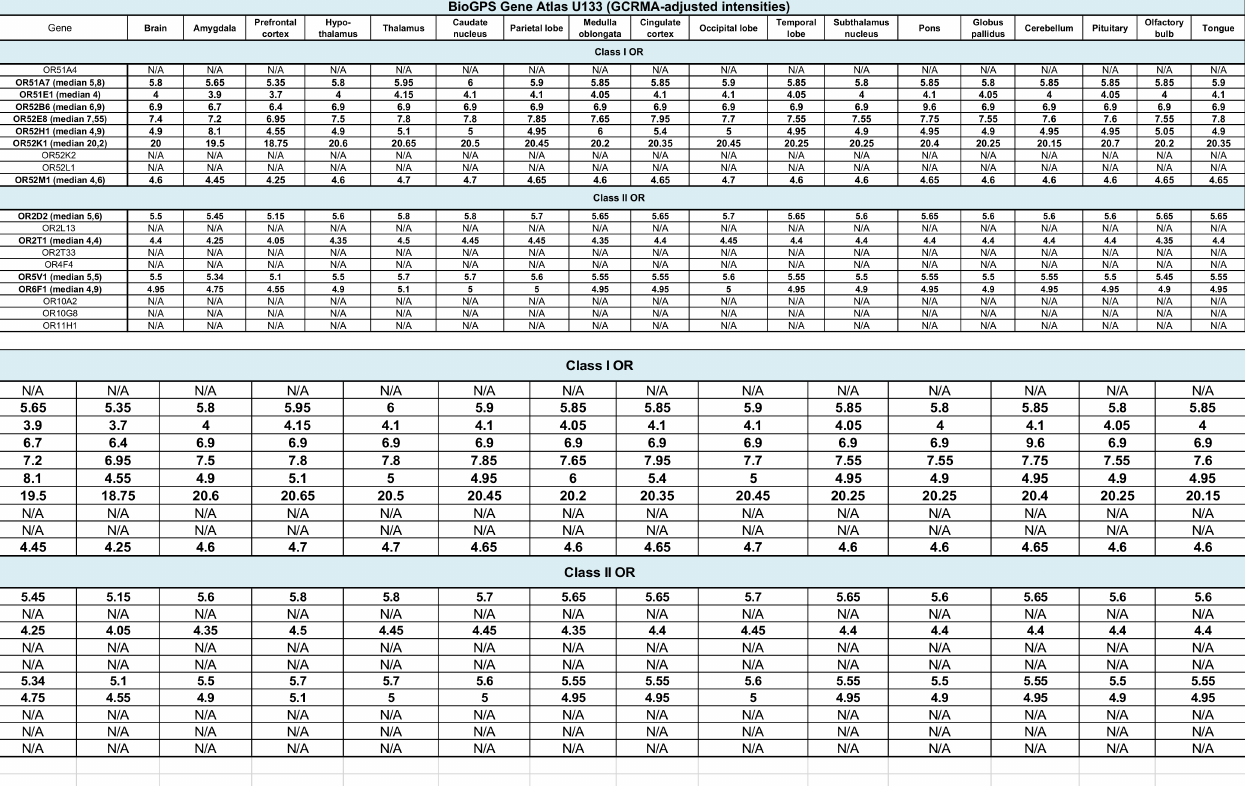
Table 1. Expression of class I and class II olfactory receptor genes in other databases. N/A, not